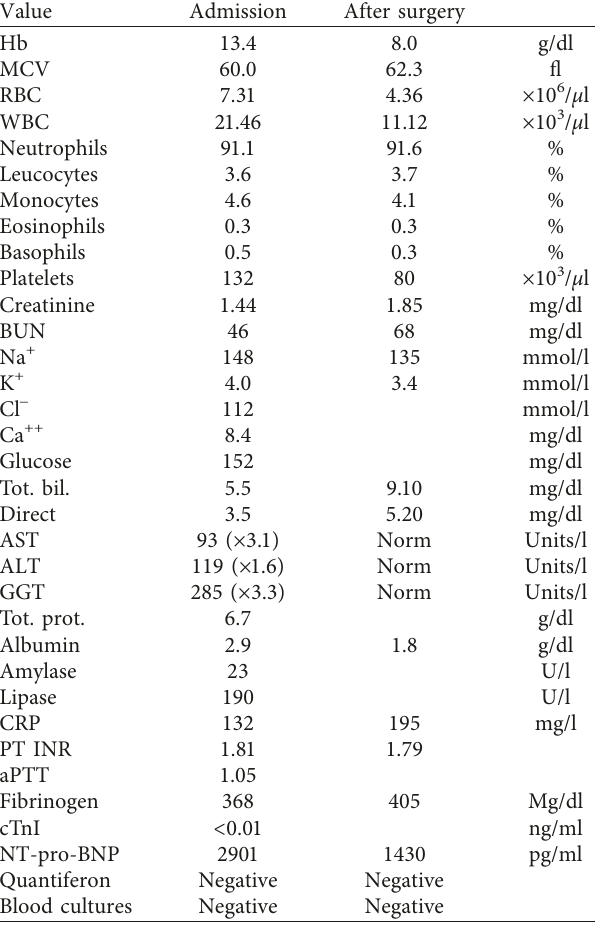
Table 1: Routine laboratory investigations.